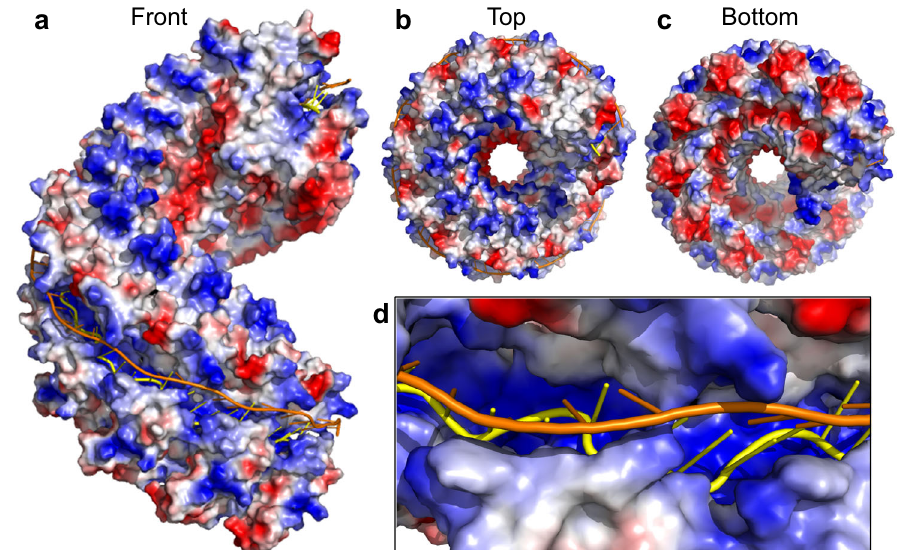
Fig. 2 | Electrostatic surface views of the LiRecT fi lament. Surface colors corre- spond to regions of positive (blue), neutral (white), and negative (red) charge. The innerDNAstrandisyellowandtheouterstrandisorange. a Frontviewshowingthe DNA bound to outer positively charged groove. b Top view showing the positively